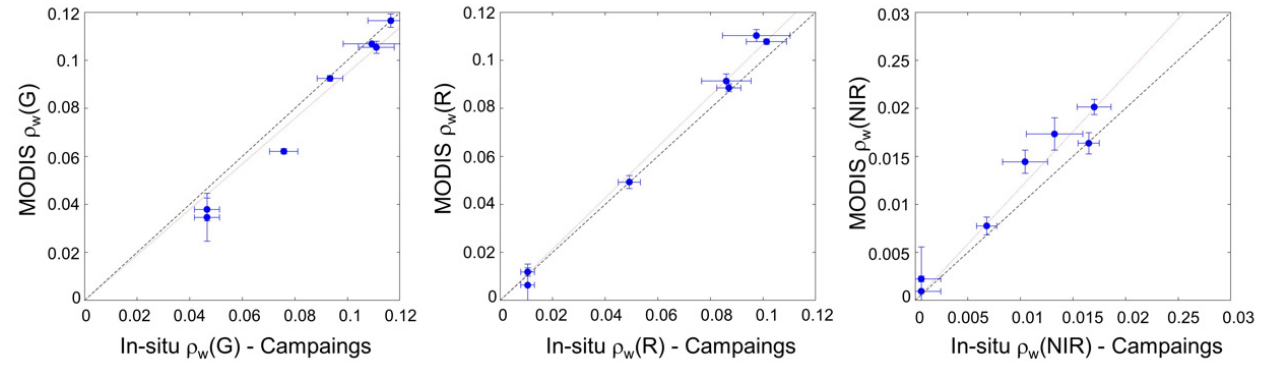
Figure A8. Water-leaving reflectance matchups obtained between the MODIS 250 m resolution green (555 nm), red (645 nm), and NIR (859 nm) bands and the in situ water-leaving reflectance data acquired in the river plume during sea campaigns.